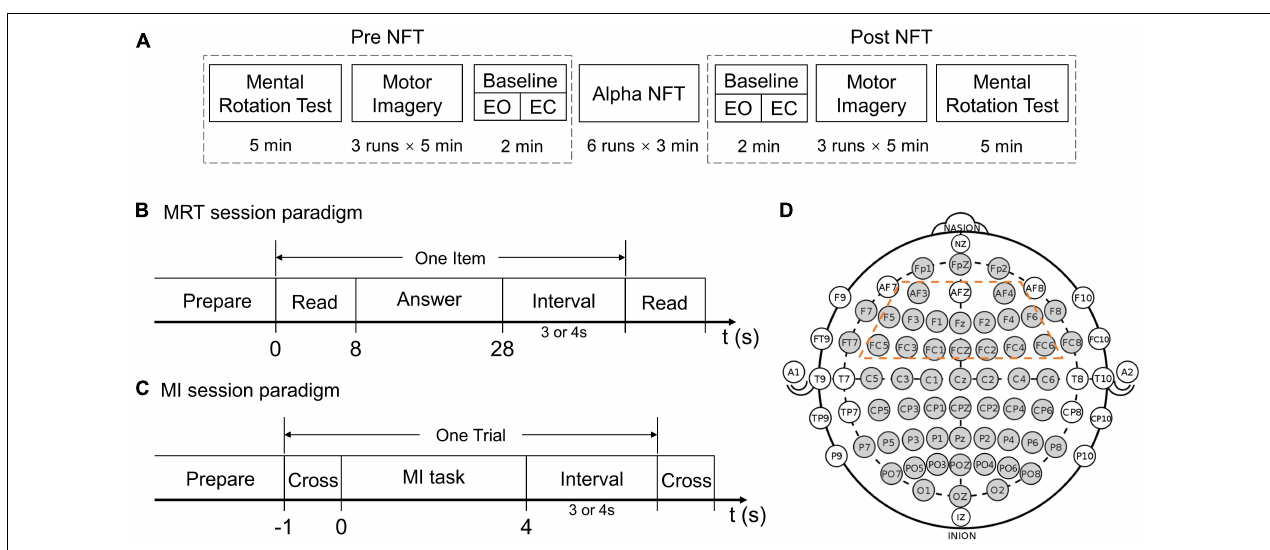
FIGURE 1 | (A) The experimental procedure. (B) Mental rotation test (MRT) session paradigm. (C) Motor imagery (MI) session paradigm. (D) The electrodes (gray) which were recorded in the international 10–20 system – the 16 electrodes circled by a dotted orange line were chosen as the target training area from the frontal